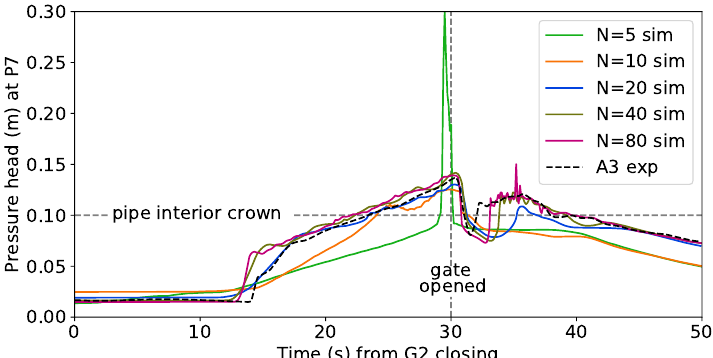
Figure 8. Pressure head at P5 sensor 2.6 m upstream of G2 for grid refinement simulations of Case A3. See Table 4 for